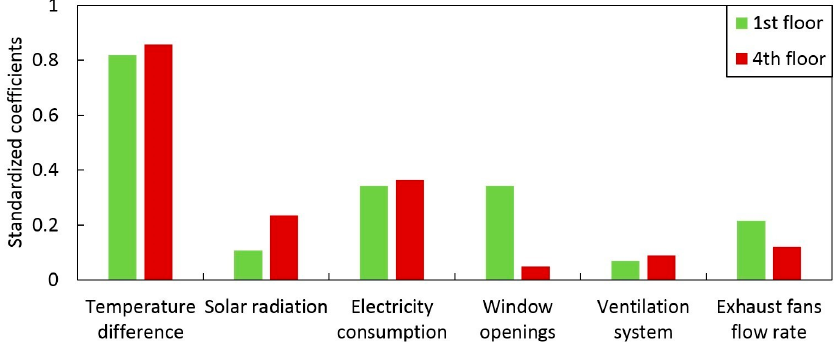
Figure 5. Average standardized coefficients for each predictors obtained from each regression model according to the apartment floor